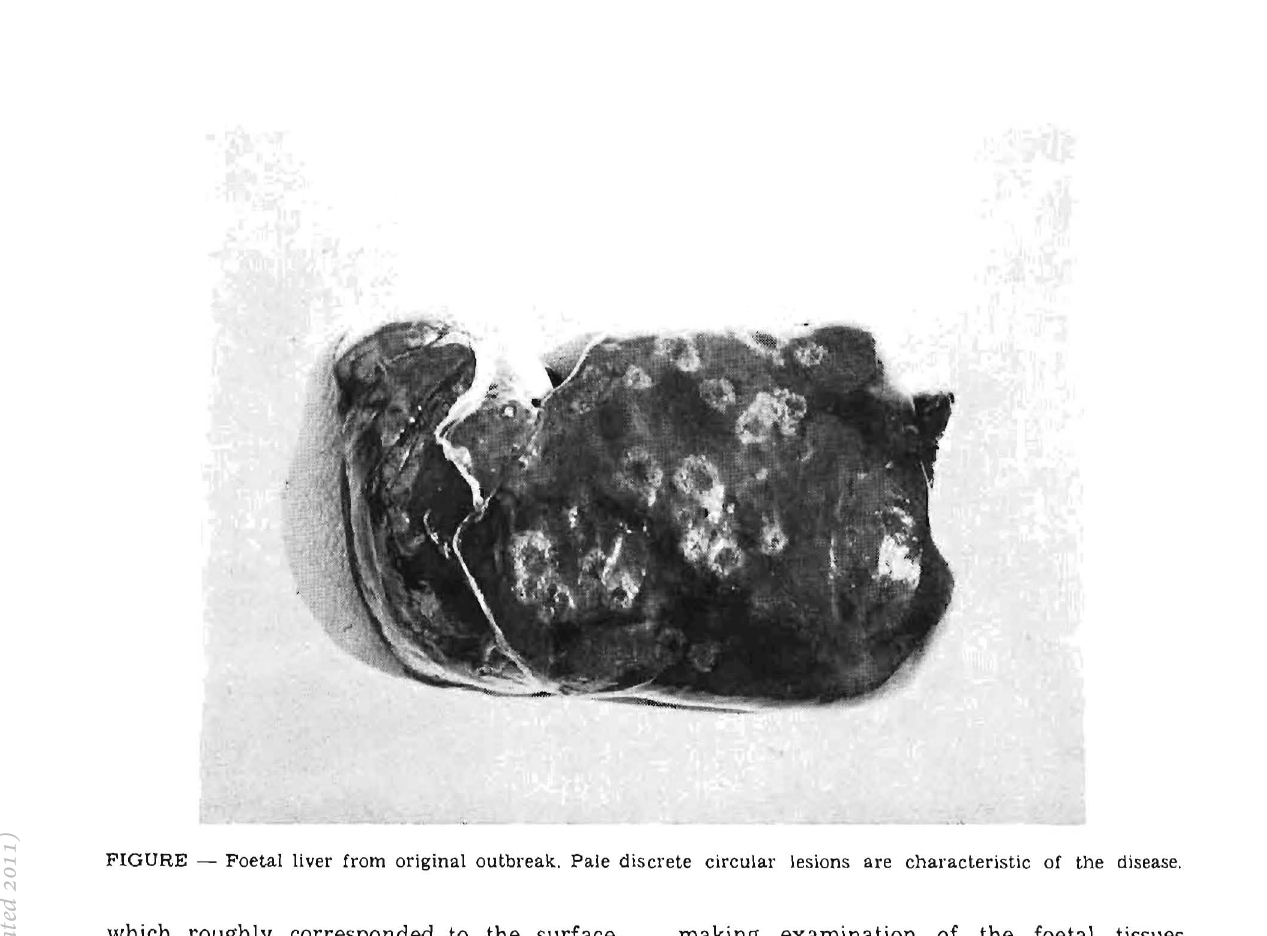
which roughly corresponded to the surface